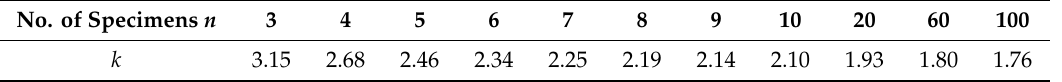
Table 5. Fractile factor k , assuming a confidence level of 75% [24].